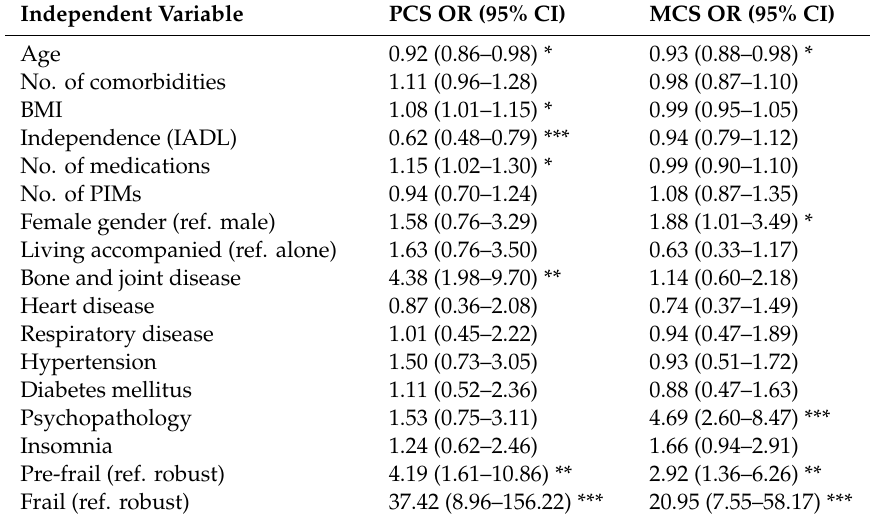
Table 5. Factors related to HRQoL. Multinomial Logistic Regression for Very Low HRQoL (with respect to Very High HRQoL) for physical and mental health components